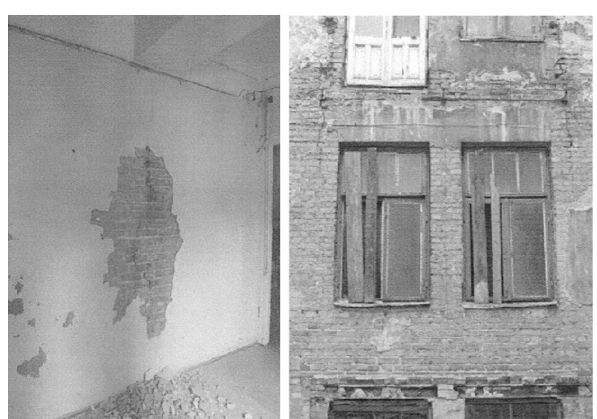
Figure 2: Examples of wall scratches (own